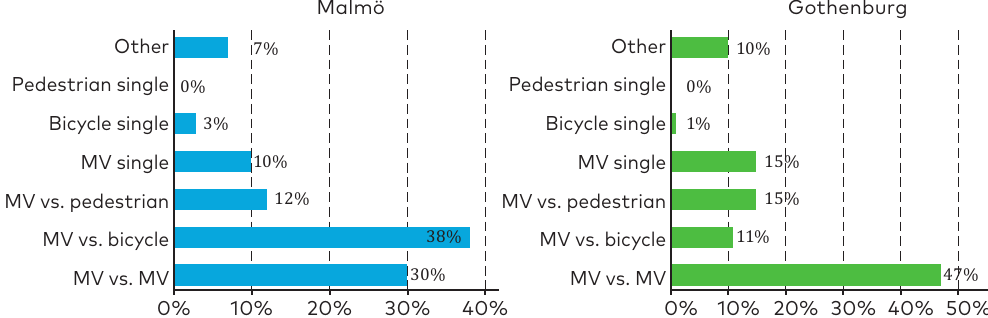
Figure 8. Distribution of personal injury accidents by involved road users in Gothenburg and Malmö, 2017 (official statistics based on police